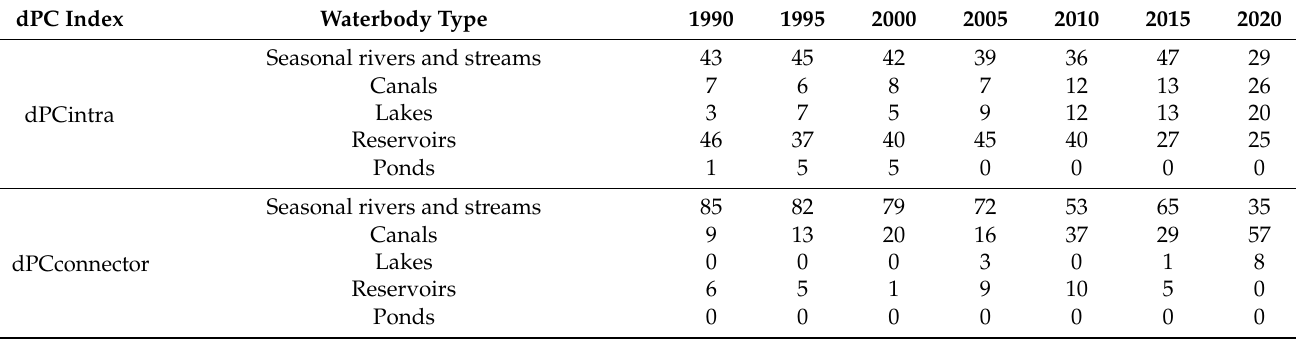
Figure 7. The contribution of individual waterbodies to overall landscape connectivity, as measured by the dPC index. For each study year from 1990 to 2020, we compared dPC between different kinds of wetlands using Kruskal – Wallis and Dunn’s tests. Test details are in Appendix B. Statistical significance was based on Bonferroni corrections. Kruskal – Wallis test statistics are shown in the plot for each year. Pairwise comparisons (a – d) are notated for significance ( p < 0.05) for Dunn’s tests. SRS indicate seasonal rivers and streams. The perennial river was excluded from analysis since it dominated all connectivity measures. Table 6. Number of waterbodies in each category that are in the top 100 for each aspect of landscape connectivity (dPCintra, dPCconnector, and dPCflux). The perennial river was excluded to better understand the changes in connectivity of the other waterbody types in Zhengzhou.